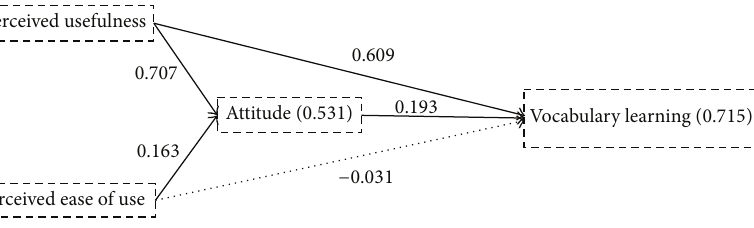
Figure 2: PLS results (brackets = 𝑅 2 for endogenous variables). Table 2: Item loadings.